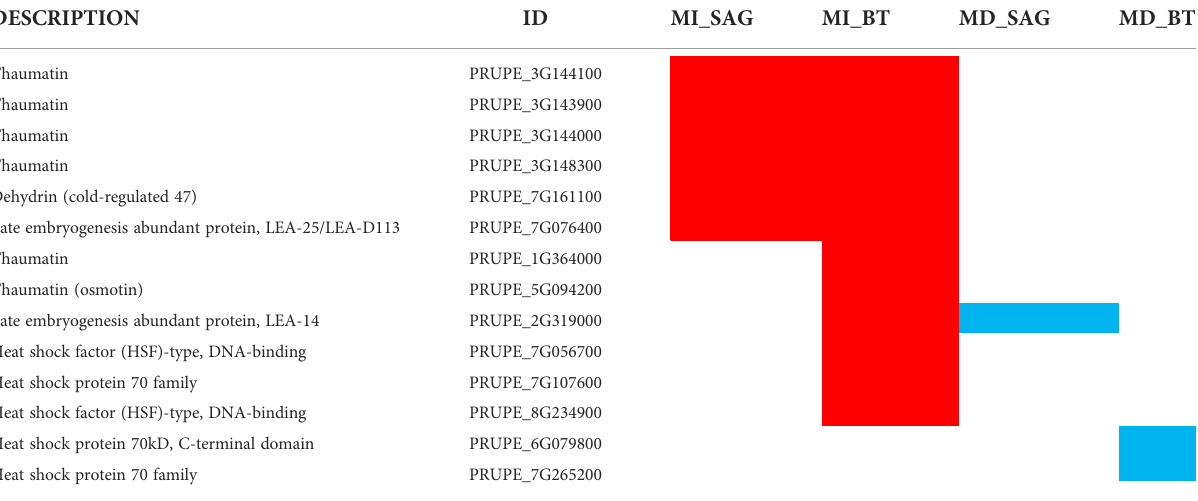
TABLE 4 Expression of monotone genes related to pathogen and stress